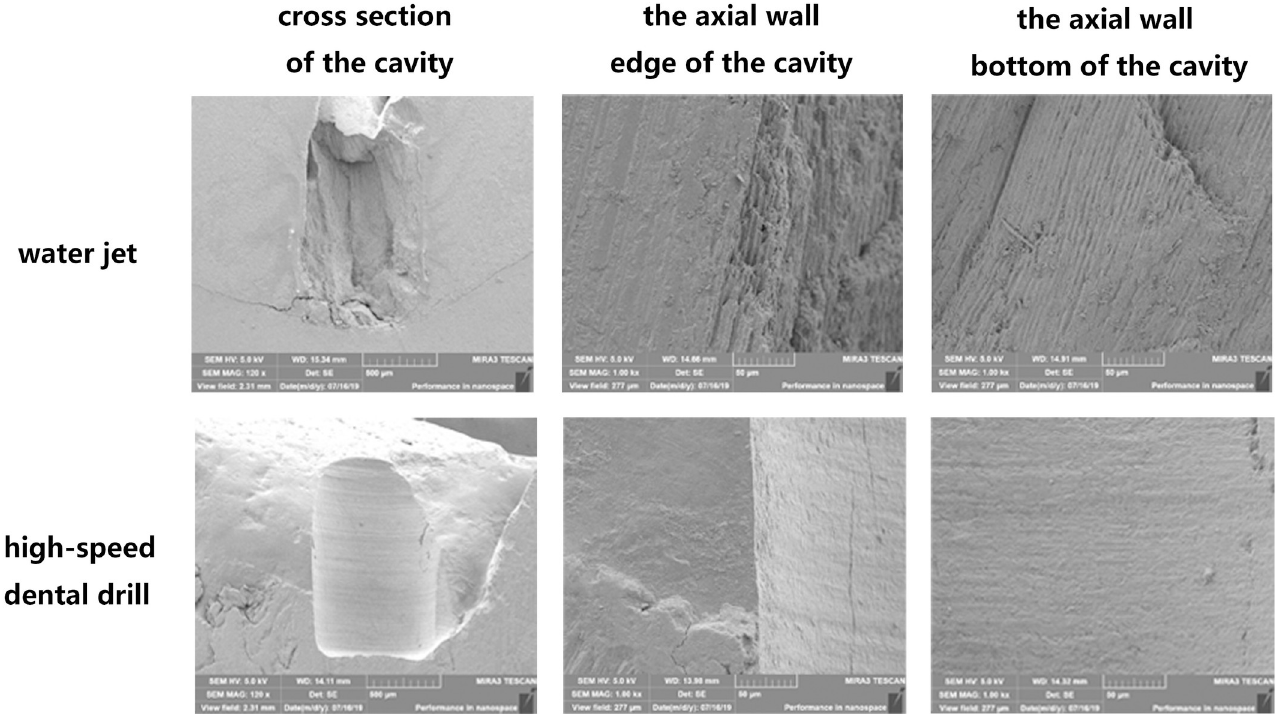
Fig 4. Observation of the drilling surface by SEM. SEM images of the cavities prepared with a water jet and a high-speed dental drill and their axial wall edge and the axial wall bottom.